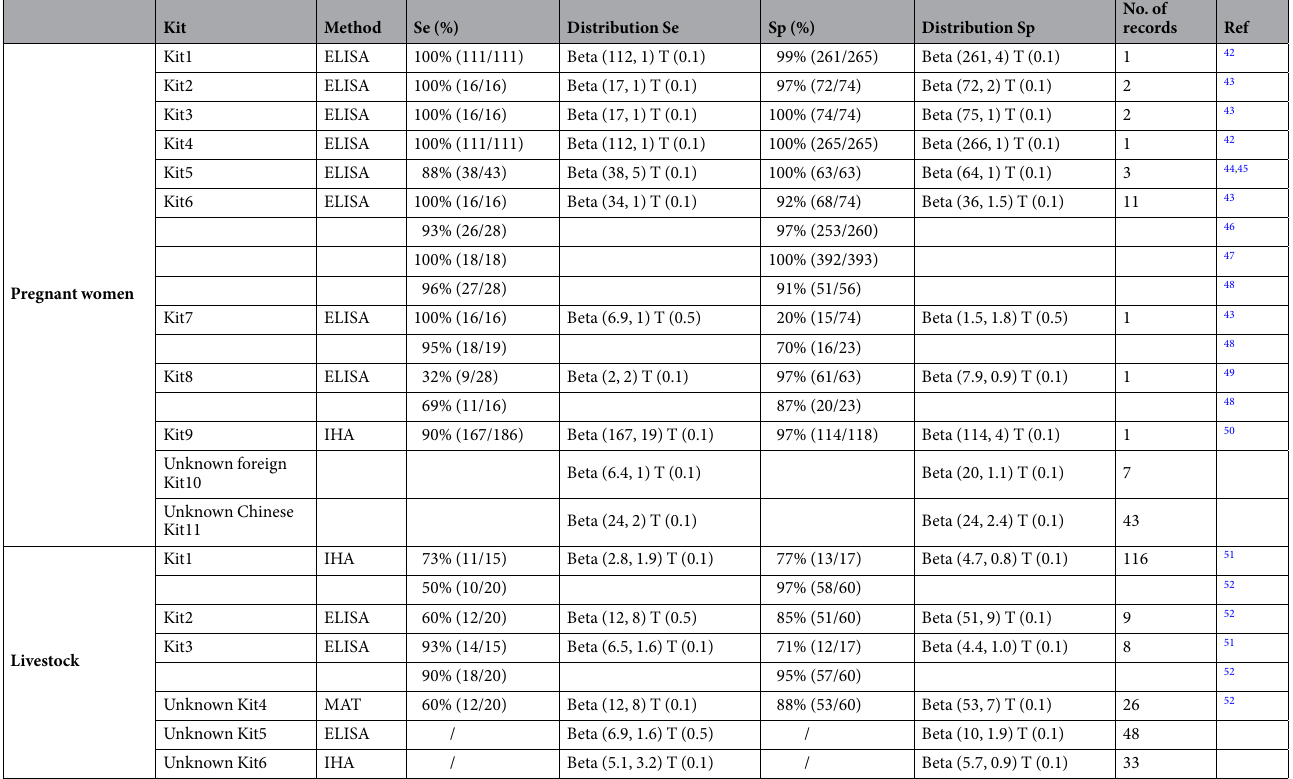
Table 3. Reported sensitivities and specificities of commercial serological kits for detection of anti- T. gondii antibodies used in records included for pregnant women and livestock and the prior distributions used in the Bayesian hierarchical model.